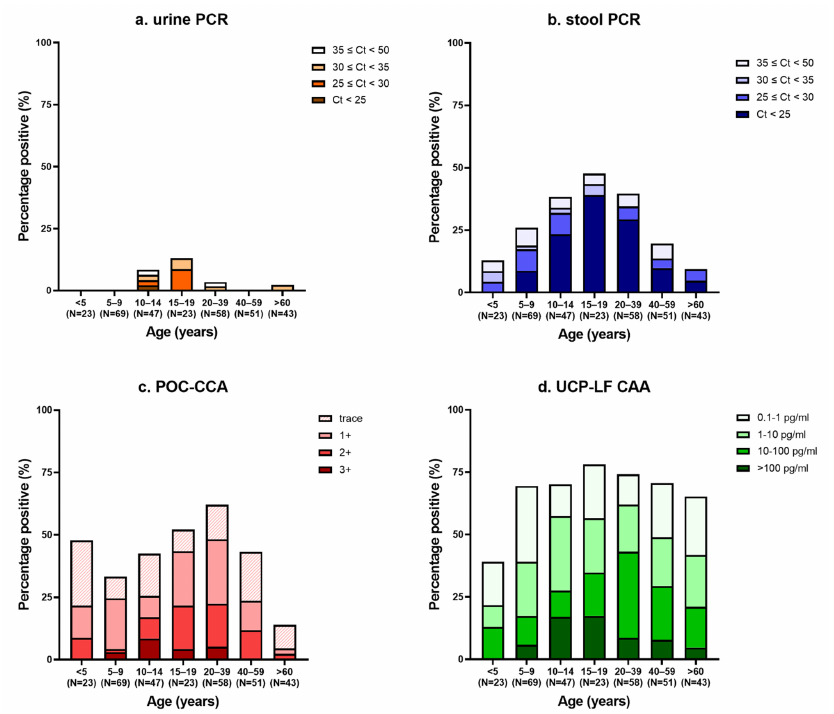
Figure 2. The intensity of infection per age group. Data based on ( a ) PCR in urine; ( b ) PCR in stool; ( c ) Point-of-care circulating cathodic antigen (POC-CCA); and ( d ) up-converting particle lateral flow circulating anodic antigen (UCP-LF CAA).